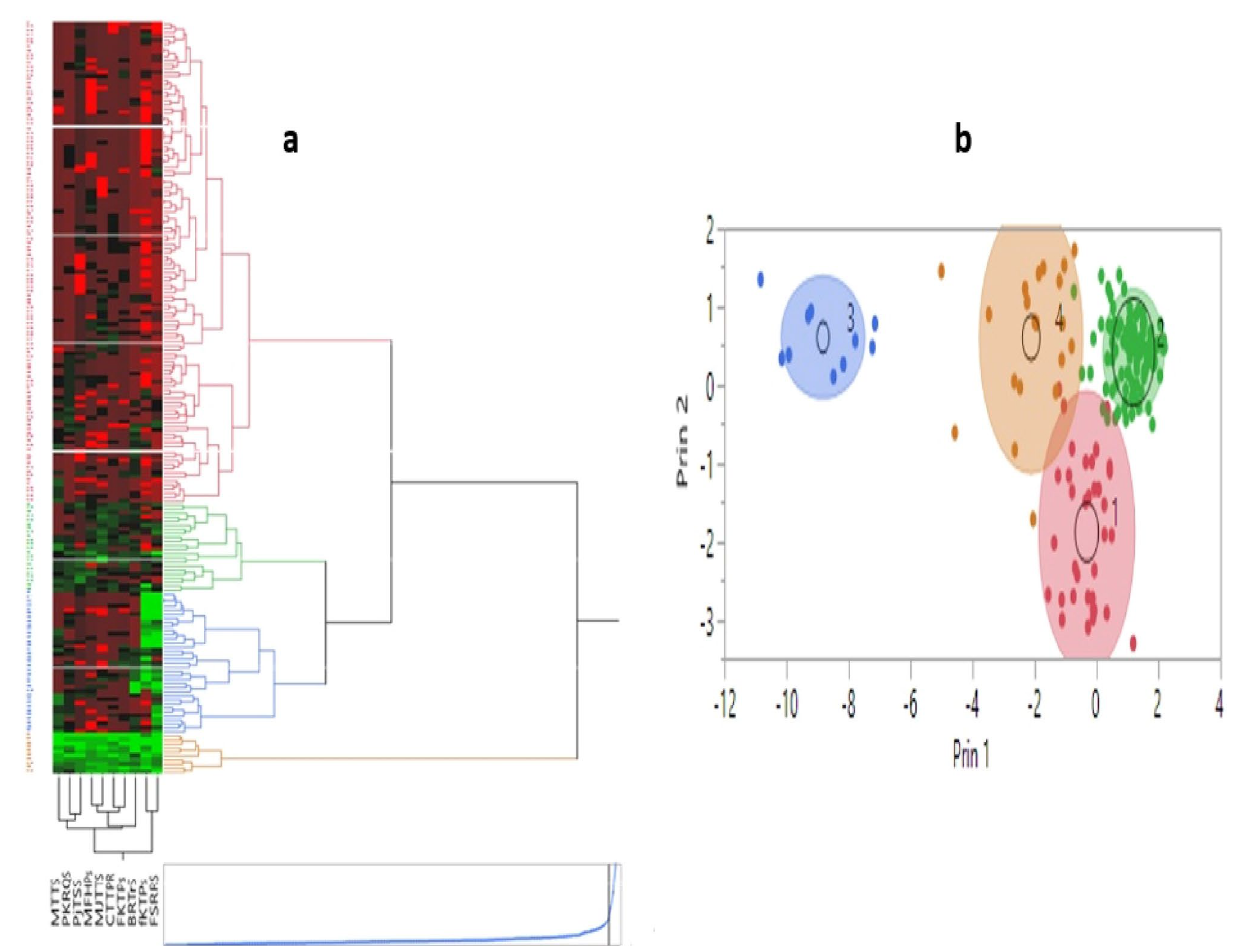
Figure 3. Cluster analysis ( a ) and principal component analysis (PCA) ( b ) of 185 wheat genotypes based on IT scores data against ten Pucnina. triticina Wheat panel diversity, population structure and LD analysis. Genotyping of 185 wheat geno- types returned a total of 94,535 raw DArT-seq markers. After marker filtering, in total 21,773 DArTseq markers (including 15,856 SilicoDArT and 5917 SNP) with MAF ≥ 5% and missing data points ≤ 20%, were used for further analysis of population structure, linkage disequilibrium and marker-trait association analysis against 10 Pt races. Analysis of genetic diversity using UNJ-clustering and Bayesian model-based structure of 185 wheat genotypes used in this study was previously described by Maboubi et al. (2022), where this wheat panel was grouped into four distinct clusters (Fig. S1). This cluster grouping was relatively consistent with the geographi-